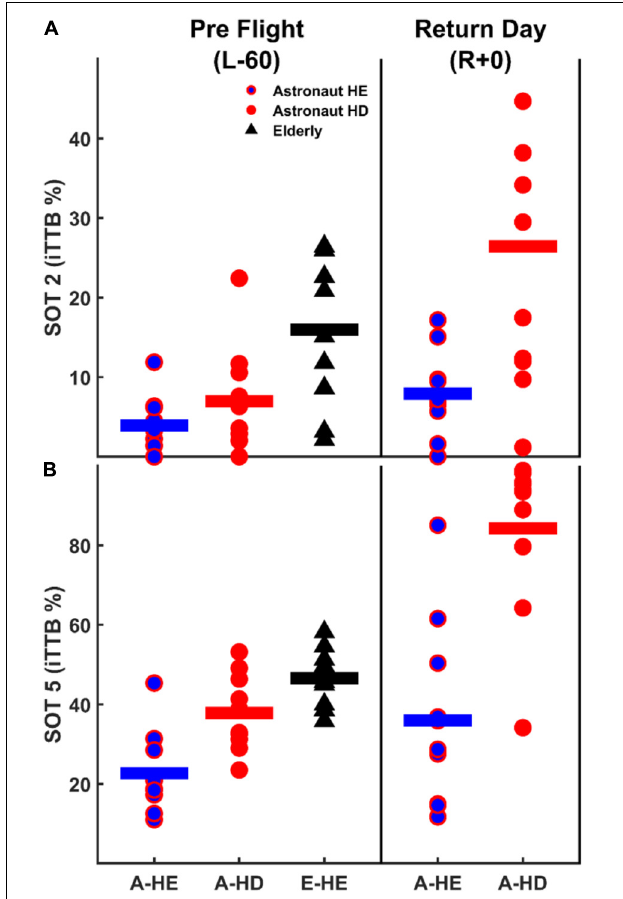
FIGURE 5 | Postural control performance comparison between the astronaut and elderly subjects before (L-60) and immediately after (R+0) spaceflight both for SOT-2 (A) and SOT-5 (B) trials. Please note that the range of ordinate is different between